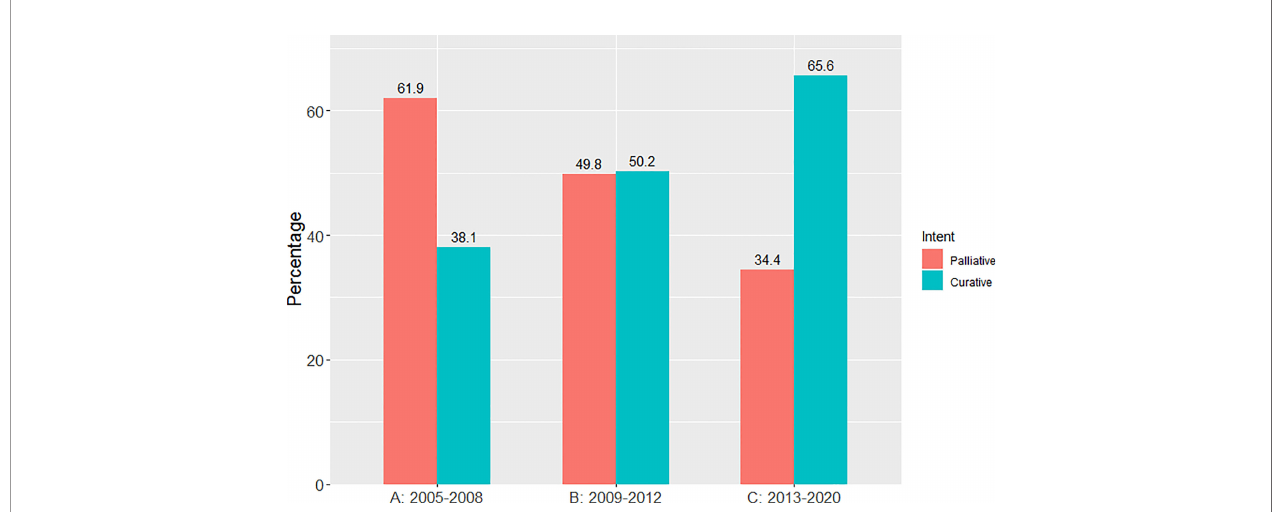
FIGURE 2 | Percentage of patients treated with curative versus palliative intent radiotherapy (whole population) in each of the pre-speci fi ed time periods.